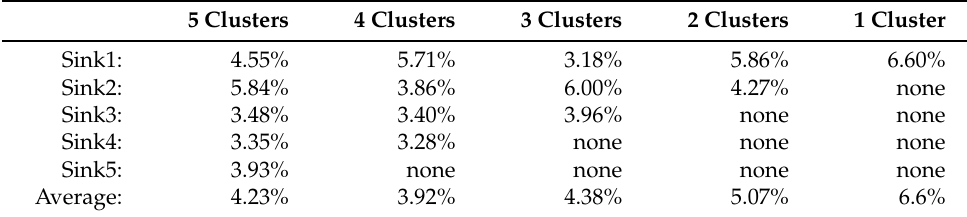
Table 3. Impact of clustering on energy consumption.